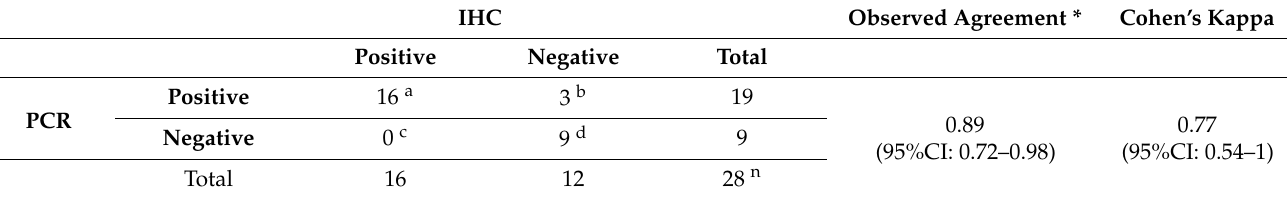
Table 3. Observed agreement of IHC and PCR